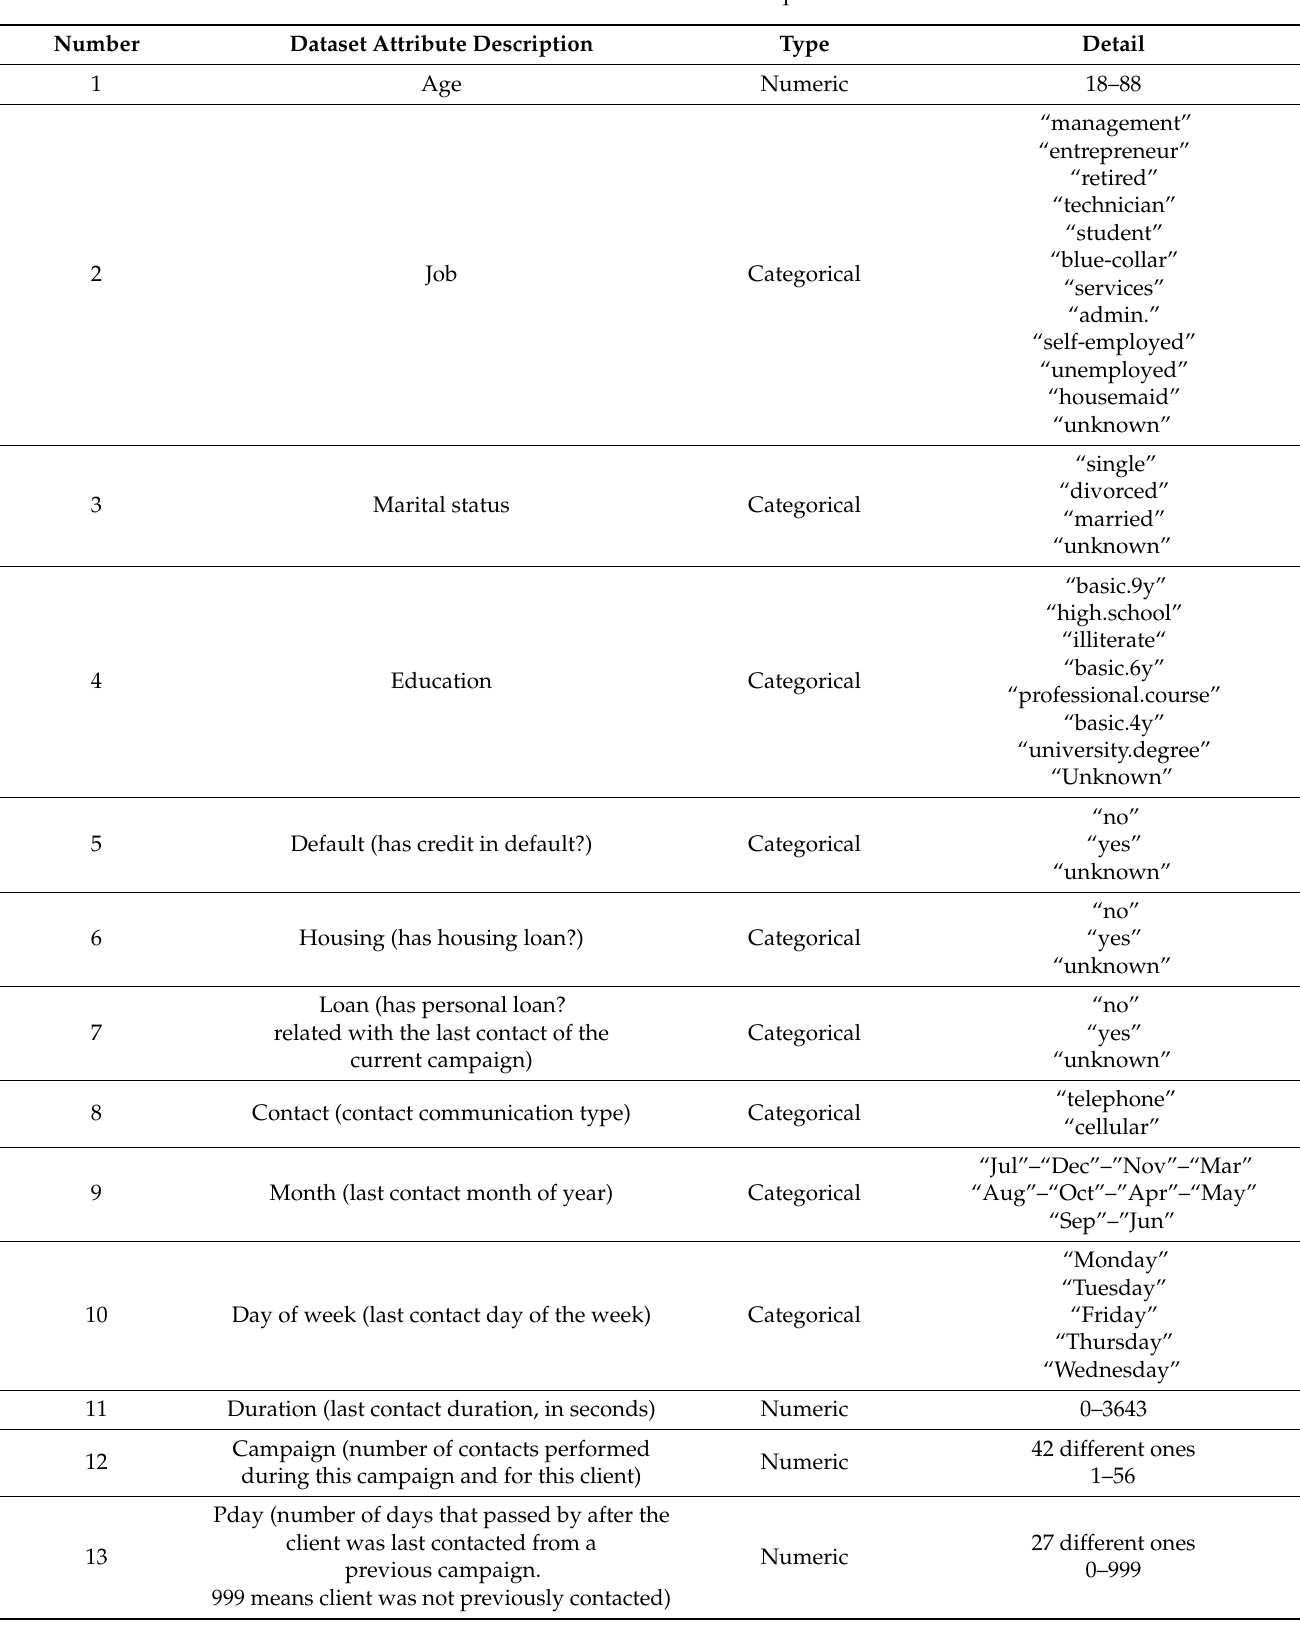
Table 1. Dataset attributes